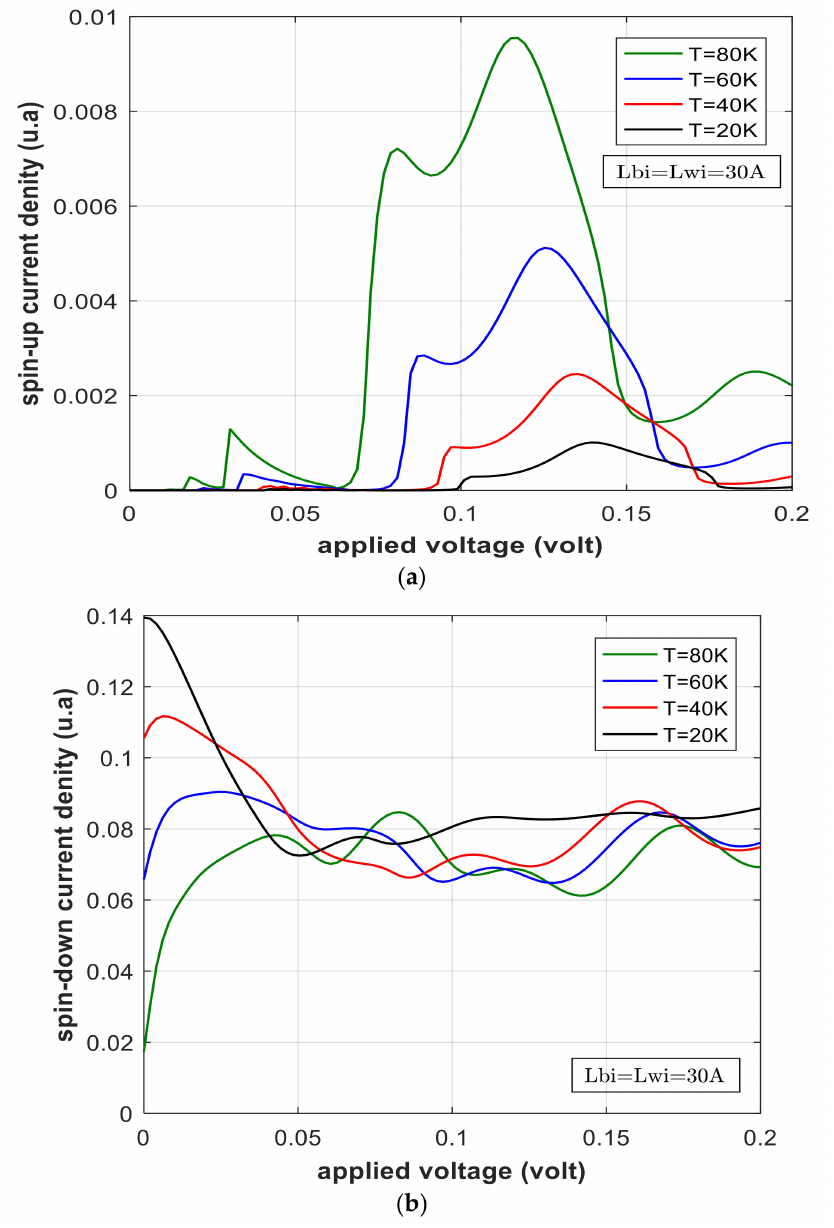
Figure 12. ( a ): Spin-up current density as a function of applied bias voltages for different temper- atures (N = 5). ( b ): Spin-down current density as a function of applied bias voltages for different temperatures (N =